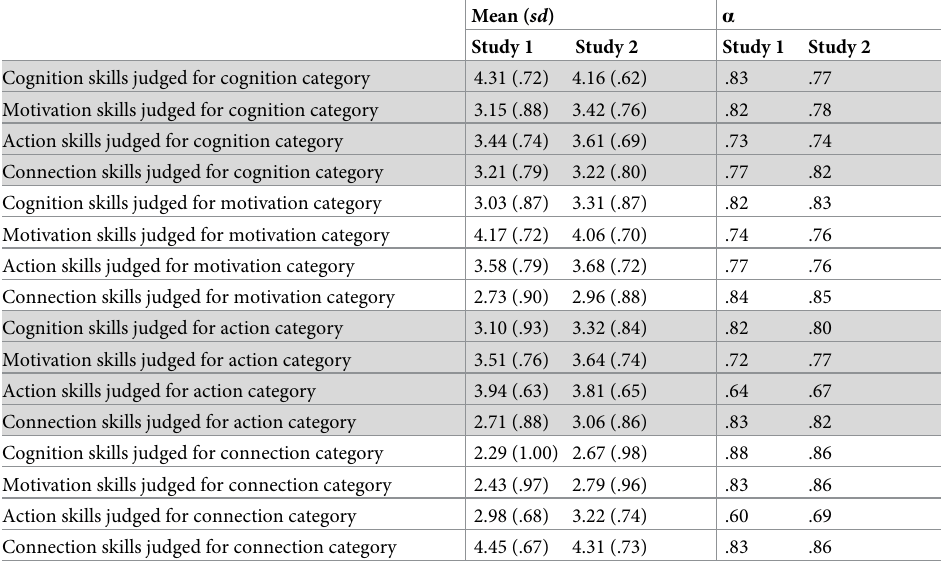
Table 1. Judgments of fit between the different skills with the four different categories in Studies 1 &